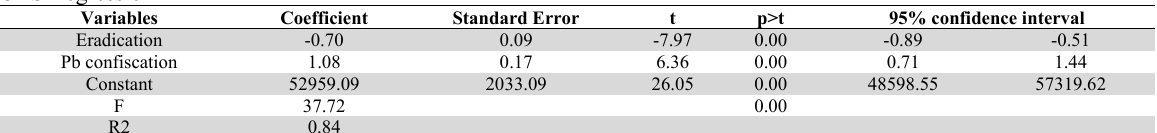
OLS Regression Variables